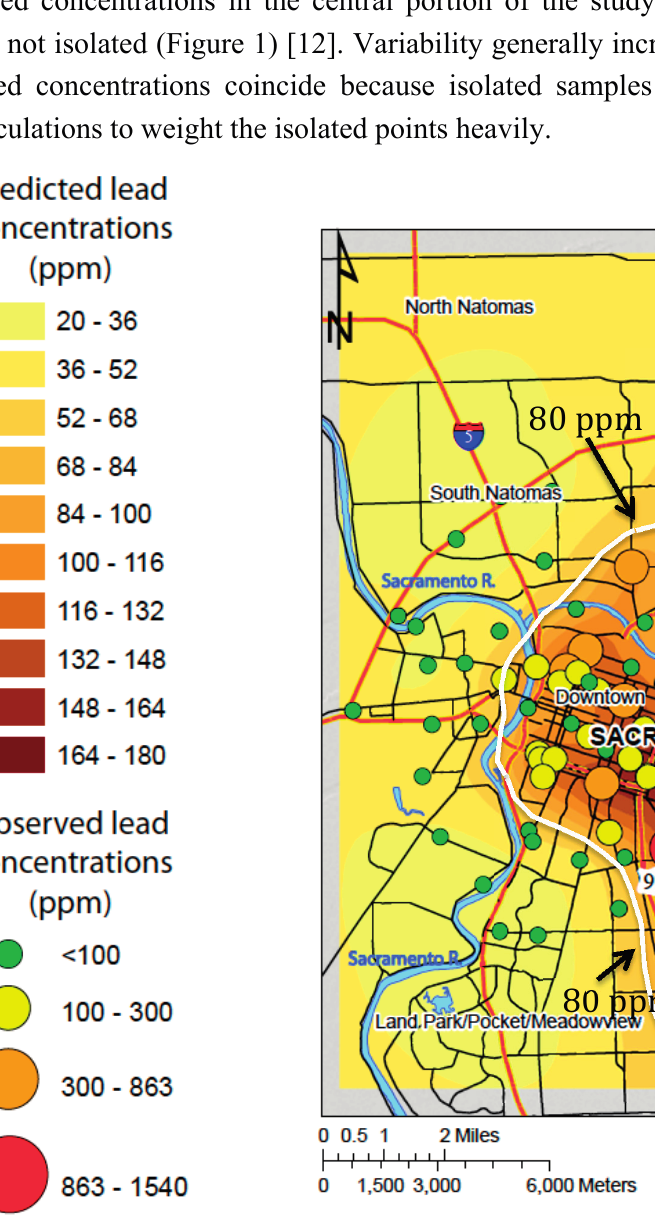
Figure 3. Prediction map of interpolated Pb concentrations in soil (filled contours) kriged using observed Pb concentrations in ssoil (red, yellow, orange, and green circles). Greater concentrations are observed and predicted in the older, downtown area of Sacramento. White line indicates the 80 ppm contour, which the revised CalEPA soil